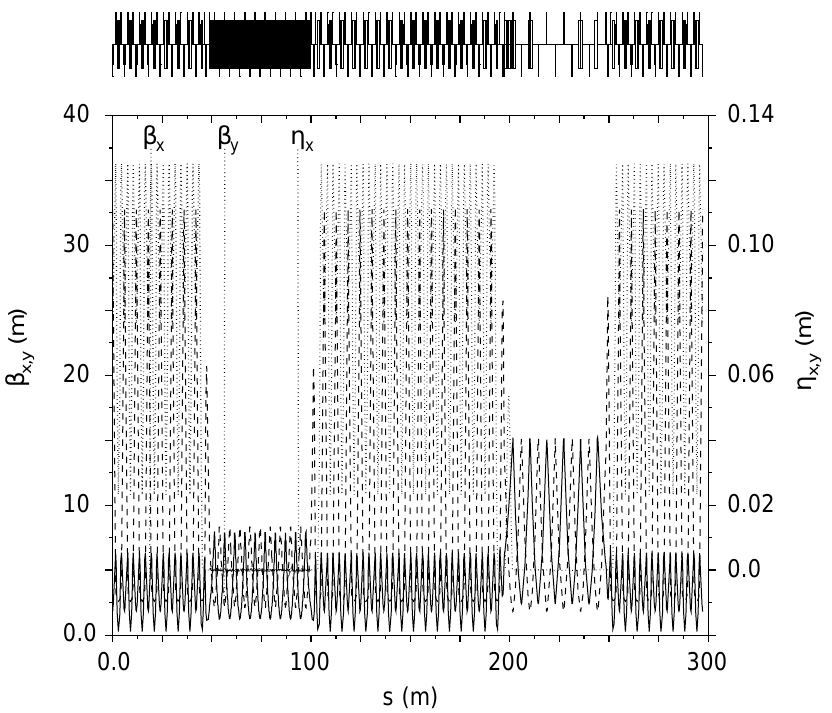
FIG. 15. Optical functions of the entire MDR. The wiggler is the darkened area at s (cid:4) 50 100 m.